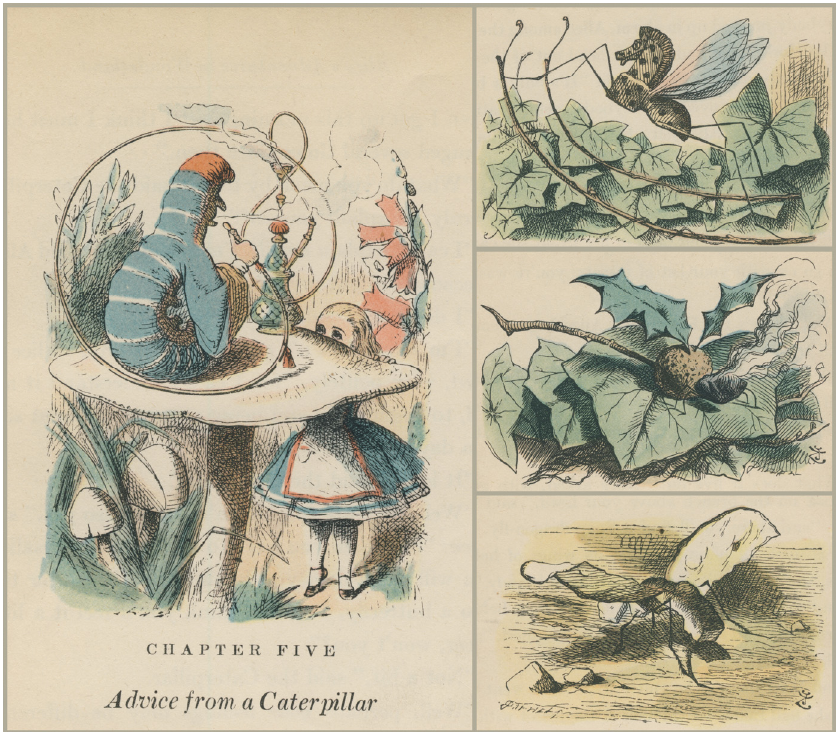
Figure 2. John Tenniel illustrated the Caterpillar (left) for Lewis Carroll’s Alice’s Adventures in Wonderland , and the Rocking-horse-fly, the Snap-dragon-fly, and the Bread-and-butter-fly (right) for Through the Looking-Glass and What Alice Found There